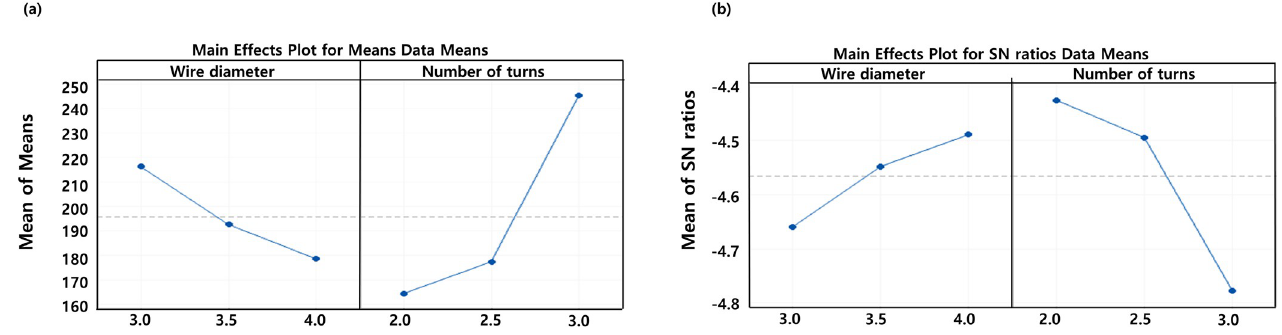
Fig 8. (a) Main effects plot of the means and (b) main effects plot of the S/N ratios (larger is better) for the maximum stress in the LIFD.